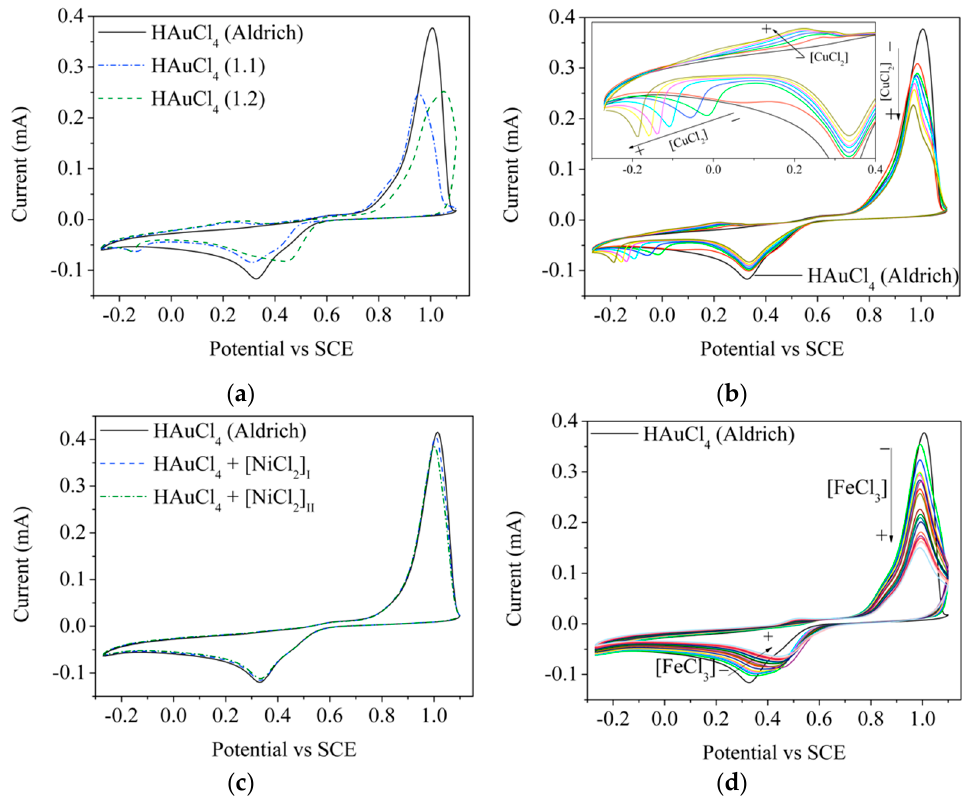
Figure 7. Cyclic voltammograms of ( a ) HAuCl 4 synthesized compared to Aldrich’s reagent (pH 1.1 = 0.60, pH 1.2 = 0.78 and pH Aldrich = 0.5), ( b ) Aldrich HAuCl 4 with and without the presence of CuCl 2 (pH = 0.69), ( c ) Aldrich HAuCl 4 with and without the presence of NiCl 2 (pH = 0.74) and ( d ) Aldrich HAuCl 4 with and without the presence of FeCl 3 (pH = 0.77).